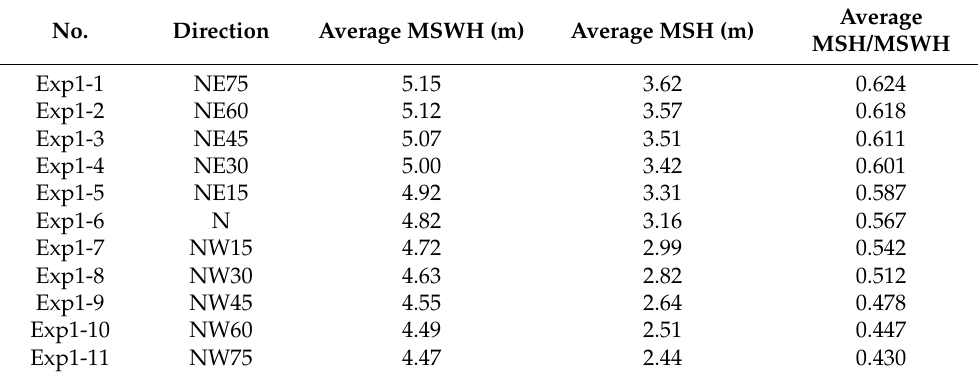
Table 2. Statistical Results of Numerical